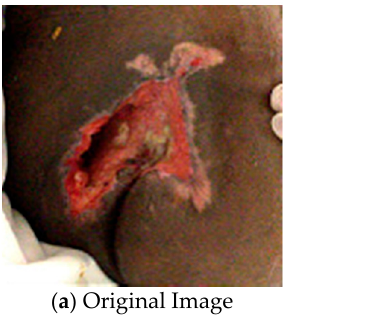
Figure 7. The probabilities of wound types: Pressure Injury: 100%, lymphovascular: 0%, surgical: 0%, diabetic: 0% (Pressure Injury).